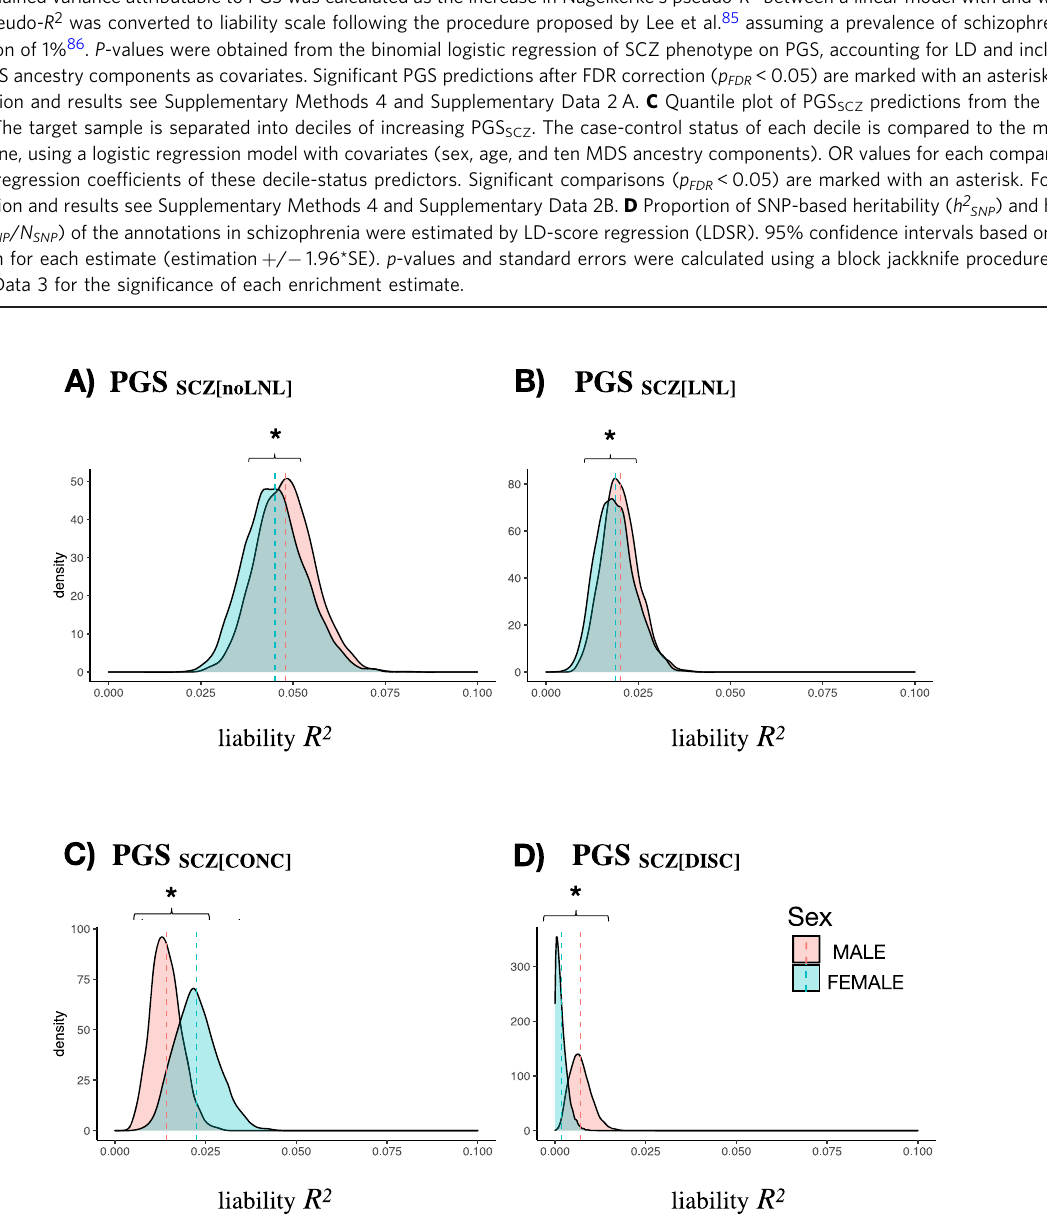
Fig. 2 Polygenic score contribution of LNL-ISO (PGS LNL-ISO ) and schizophrenia (PGS SCZ ) to schizophrenia risk and heritability estimates. A PGS predictions of LNL-ISO (PGS LNL-ISO ) and its constituent phenotypes (see legend) on an independent schizophrenia case-control sample ( N SCZ = 1927; N = 1561). Explained variance attributable to PGS was calculated as the increase in Nagelkerke ’ s pseudo- R 2 between a linear model with and without the HC PGS variable. P -values were obtained from the binomial logistic regression of SCZ phenotype on PGS, accounting for Linkage Disequilibrium (LD) and including sex, age, and ten multidimensional scalings (MDS) ancestry components as covariates. Signi fi cant PGS predictions after FDR correction ( p FDR < 0.05) are marked with an asterisk. See Supplementary Fig. 1 for R 2 values for PGS predictions on the liability scale estimated using UK Biobank prevalence for LNL-ISO constituent phenotypes. For a full detailed description and results see Supplementary Methods 3 and Supplementary Data 1. B PGS